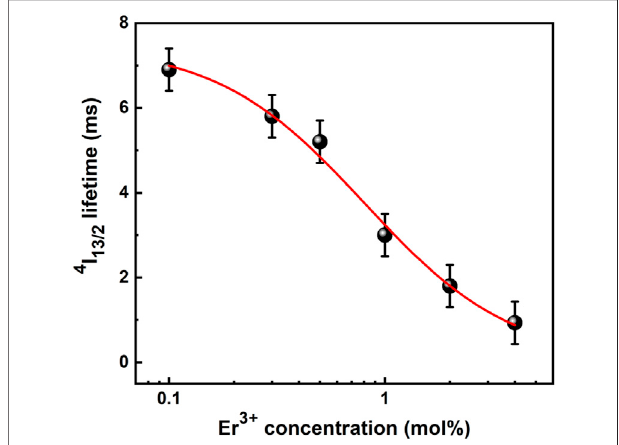
FIGURE11| Lifetimevaluesofthe 4 I 13/2 → 4 I 15/2 transitionofEr 3+ -doped SiO 2 -Ta 2 O 5 based waveguides as a function of Er 3+ doping concentrations (from 0.1 to 4.0 mol%). The best fi t is represented by the red